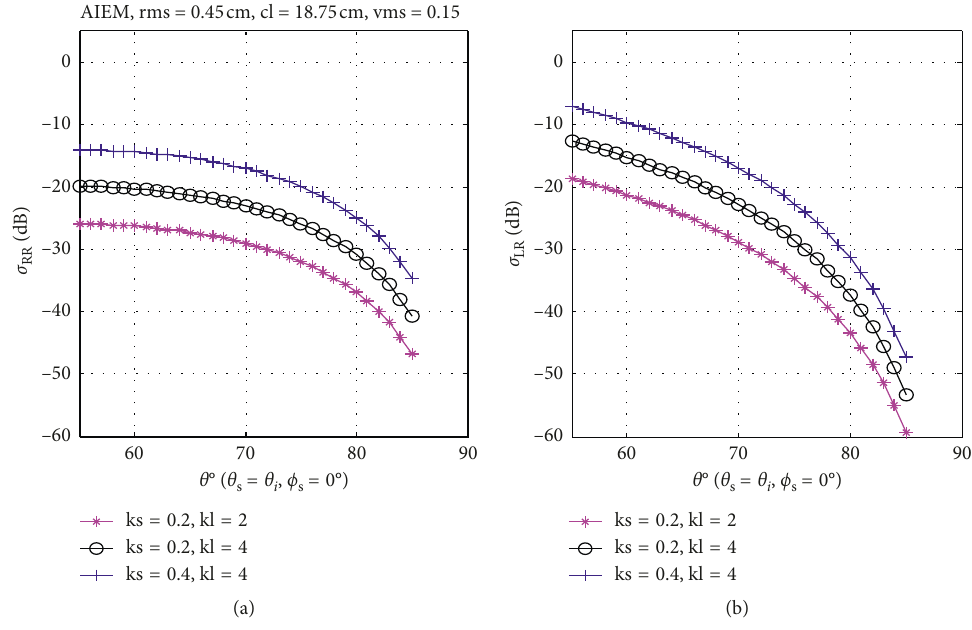
Figure 5: Surface roughness effects on the RR and LR